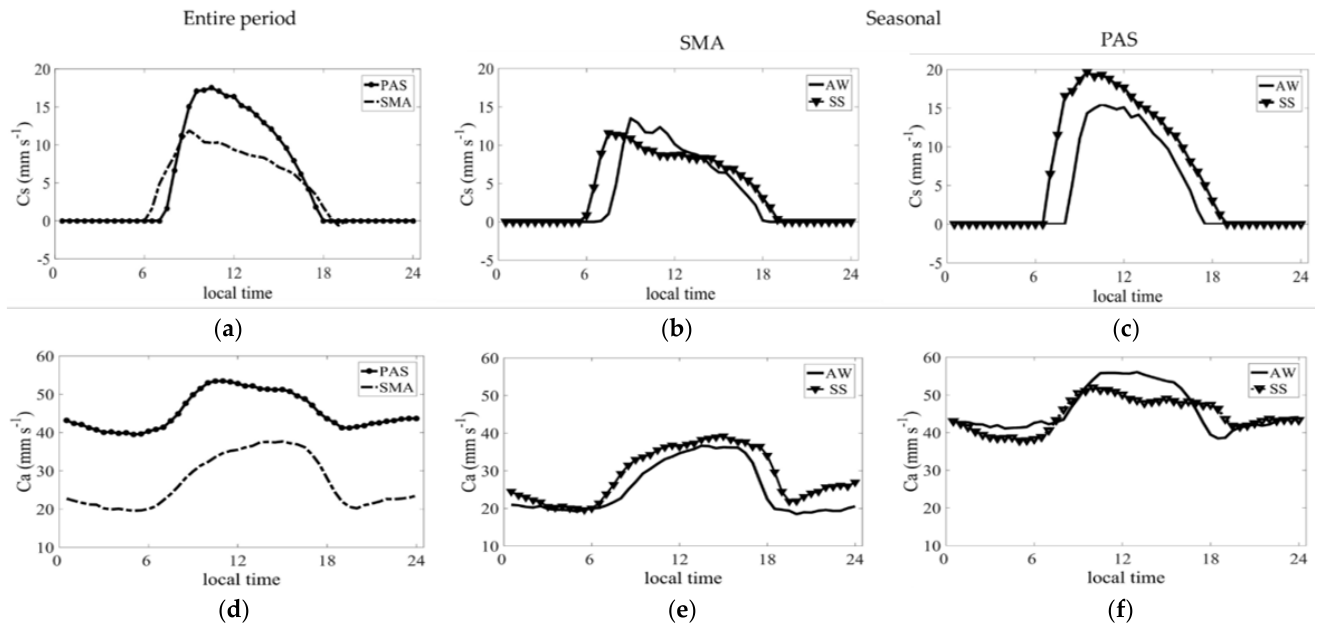
Figure 6. Average daily cycles of surface conductance ( Cs , mm s − 1 ) ( a – c ) in top panels and aerodynamic conductance ( Ca , mm s − 1 ) ( d – f ) in bottom panels for the Pampa biome, at the SMA and PAS sites, on the left column for the entire study period, on central for SMA in the AW and SS periods, and on right for PAS in the AW and SS periods.